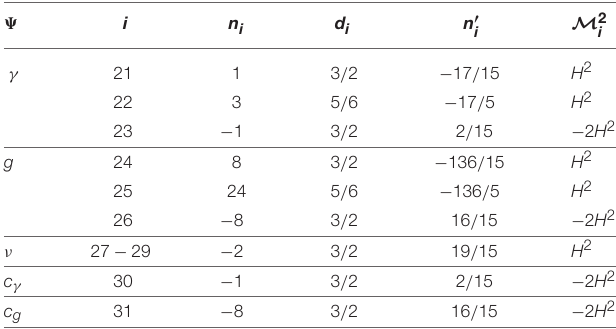
TABLE 2 | Contributions to the effective potential (3.32) with no coupling to the Higgs at